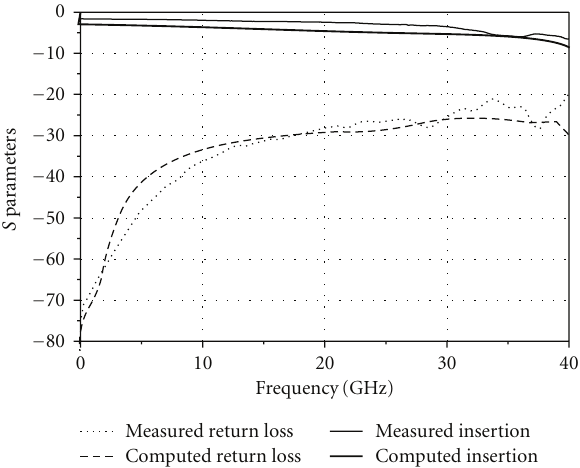
Figure 3: Comparison of the NEMS switch on the “on”